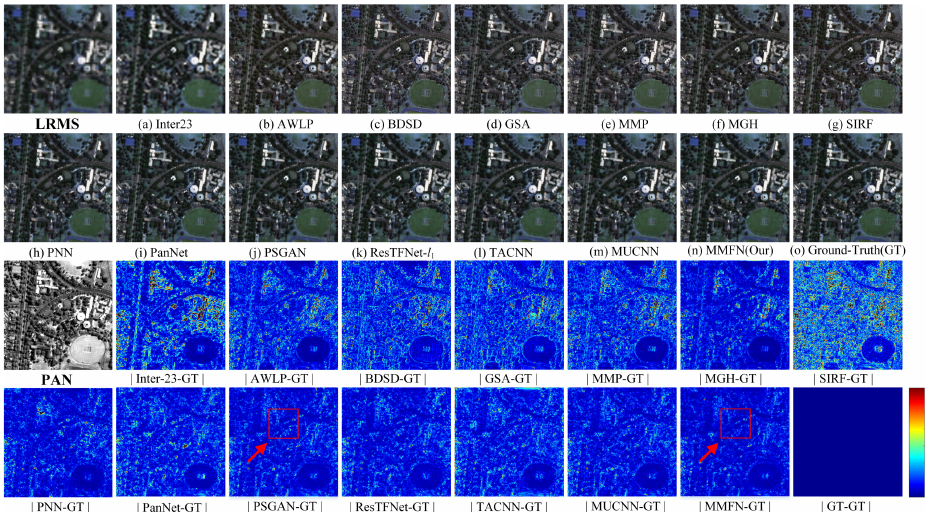
Figure 4. Qualitative comparison at reduced resolution on the Pléiades dataset. ( a ) Inter23, ( b ) AWLP, ( c ) BDSD, ( d ) GSA, ( e ) MMP, ( f ) MGH, ( g ) SIRF, ( h ) PNN, ( i ) PanNet, ( j ) PSGAN, ( k ) ResTFNet- l 1 , ( l ) TACNN, ( m ) MUCNN, ( n ) MMFN, ( o ) Ground-Truth (GT). The last two rows are MAEs between pansharpened results and the related ground-truth